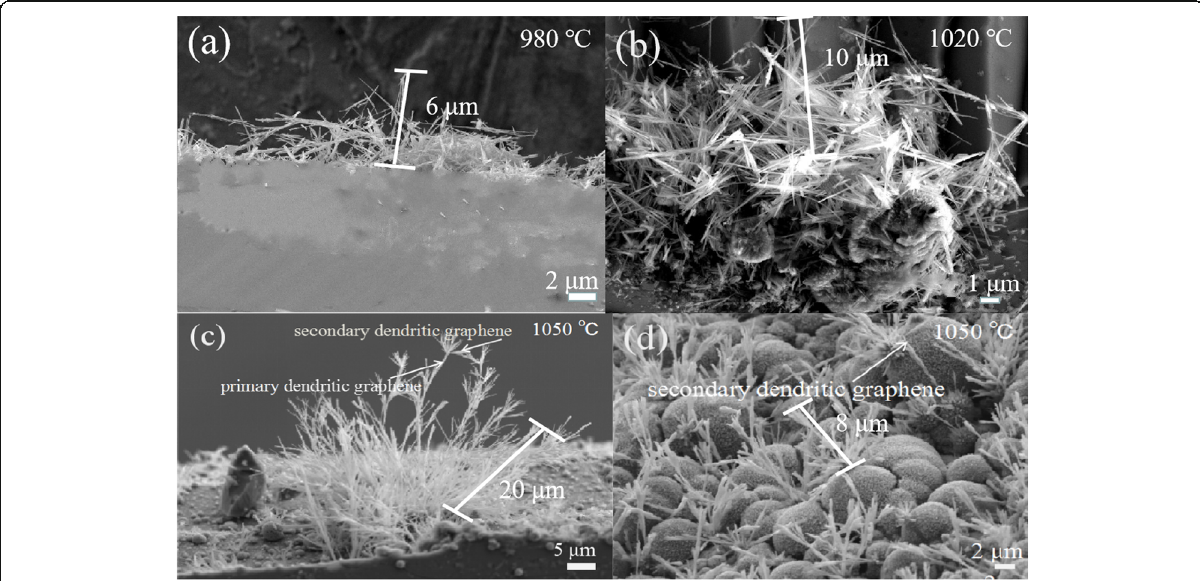
Fig. 2 SEM images of graphene dendrites synthesized on Si surface of the SiO 2 /Si substrates at the growth temperature of 980 °C ( a ), 1020 °C ( b ), and 1050 °C ( c ), and on SiO 2 surface of the SiO 2 /Si substrates at 1050 °C ( d ). The growth time was 120